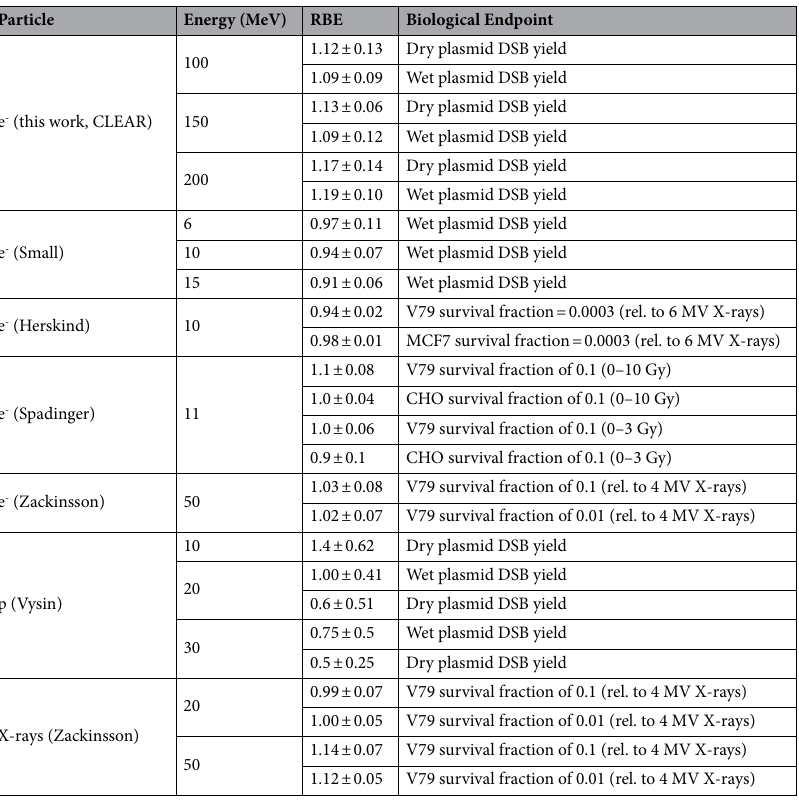
Table 5. RBE for various particle modalities with particle, energy and biological endpoint specified. Standard error of the mean for Small data calculated based on gel repeats. RBE data taken or calculated from references 27–31 . All RBE calculations relative to 60 Co X-ray data unless